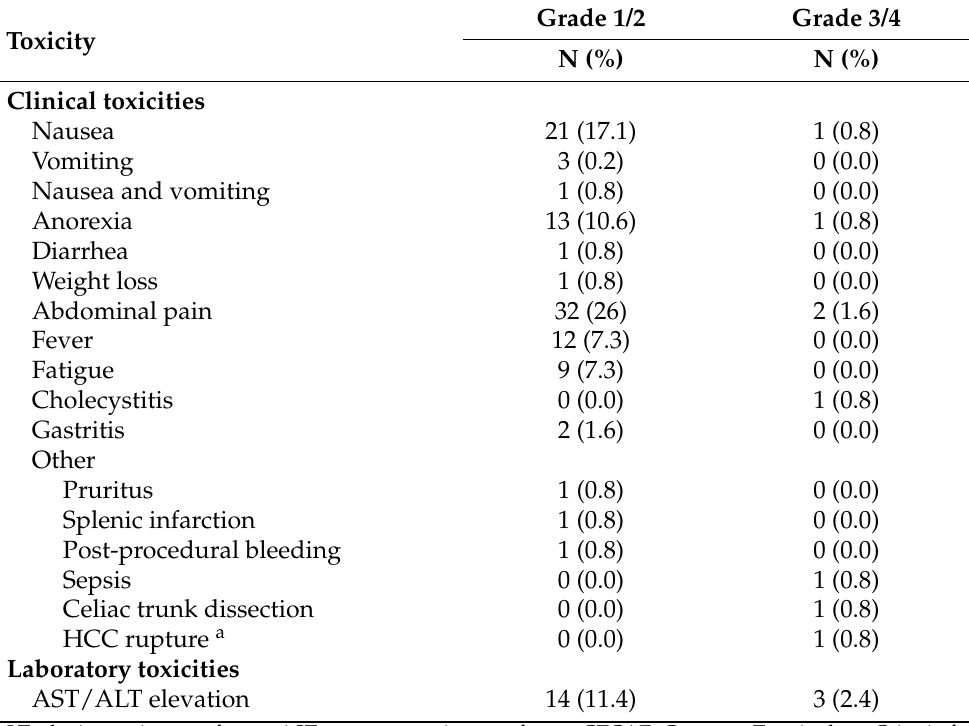
Table 5. Clinical and laboratory toxicity after TARE graded by CTCAE